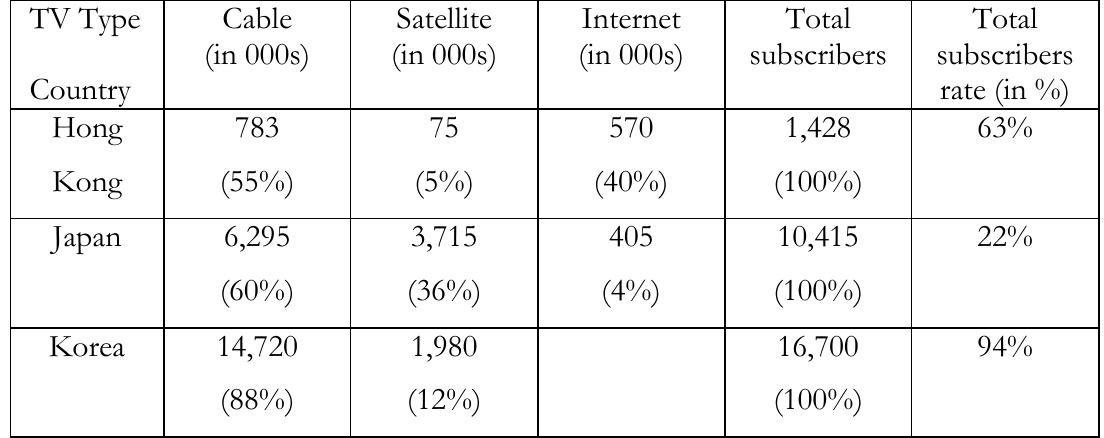
Table 1: Pay Television Subscribers (as of December